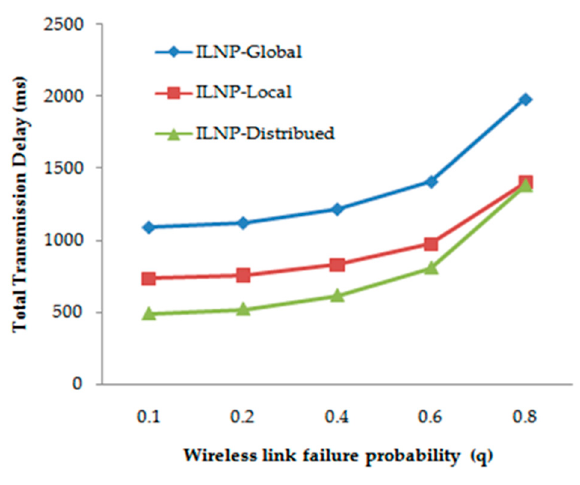
Figure 12. Impact of L wl on TTD.